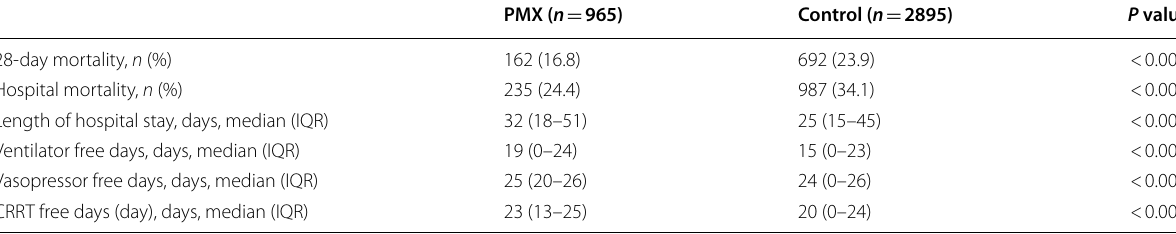
IQR Interquartile range, CRRT Continuous renal replacement therapy